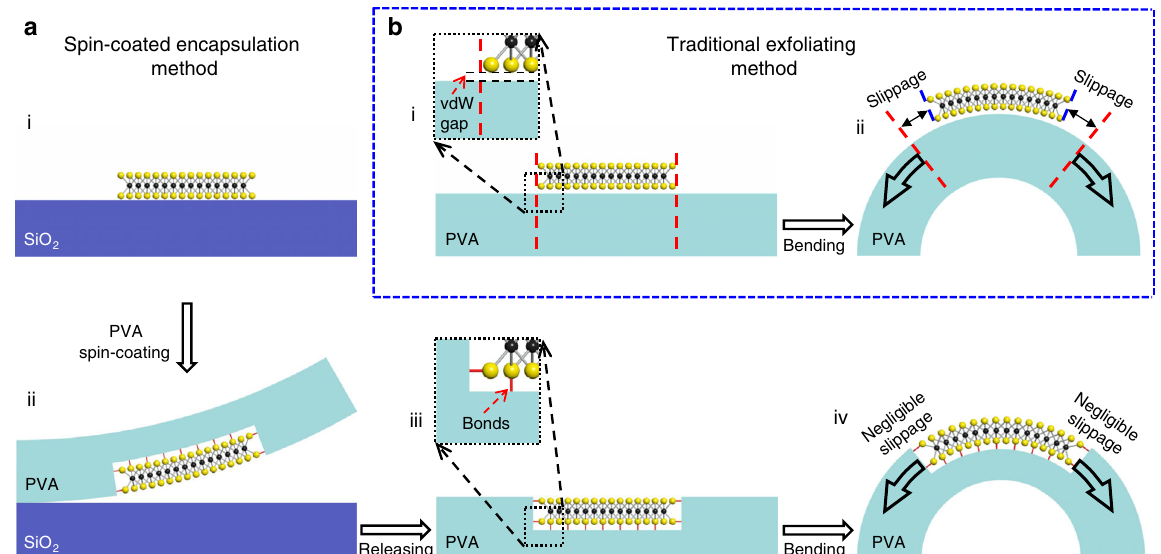
Fig. 1 Schematical illustration of fabrication processes of spin-coated encapsulation method and traditional exfoliating method. a Schematic fabrication processes of PVA-encapsulation method with four steps: (i) MoS 2 exfoliation on SiO 2 substrate, (ii) PVA spin-coating and fully encapsulation of MoS 2 with strong interaction force in between, (iii) PVA/MoS 2 released from SiO 2 substrate, (iv) bended under strain test equipment with negligible slippage. b Schematic fabrication processes of traditional exfoliating method with two steps: (i) MoS 2 direct exfoliation on top of the pre-fabricated PVA substrate, (ii) bended under strain test equipment. Due to the weak vdW force between PVA and MoS 2 , large slippage could happen under tension strain, as highlighted by the distance between the red dash line (ideal position without slippage) and the blue dash line (actual 2D material edge with